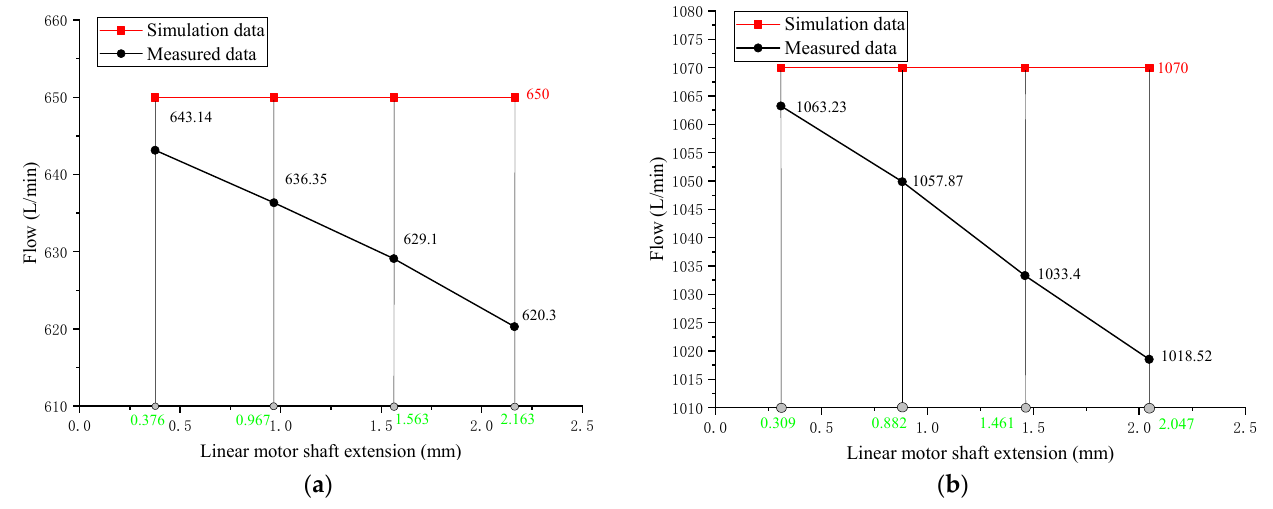
Figure 13. Pressure curves under simulated and actual working conditions: ( a ) Emulsion pump with theoretical flow of 650 L/min; ( b ) Emulsion pump with theoretical flow of 1070 L/min.